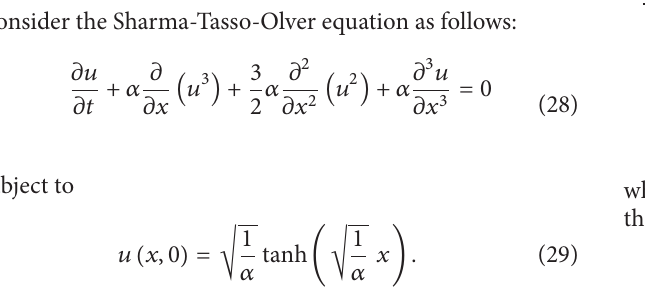
Figure 2: (a) Absolute error |𝑢(1,0.1) − 𝑢 (1, 0.3)| with 𝑛 = 11 , when −8 ≤ 𝛼 ≤ 8 . error |𝑢(1,0.3) − 𝑢 app